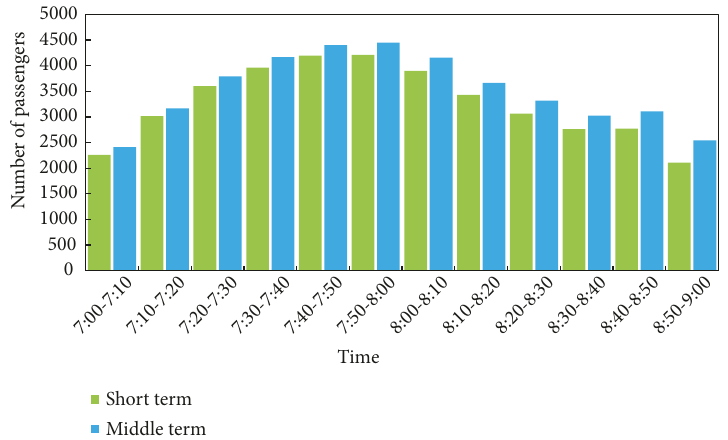
Figure 5: Distribution of potentially influenced passengers in the short term and middle term.